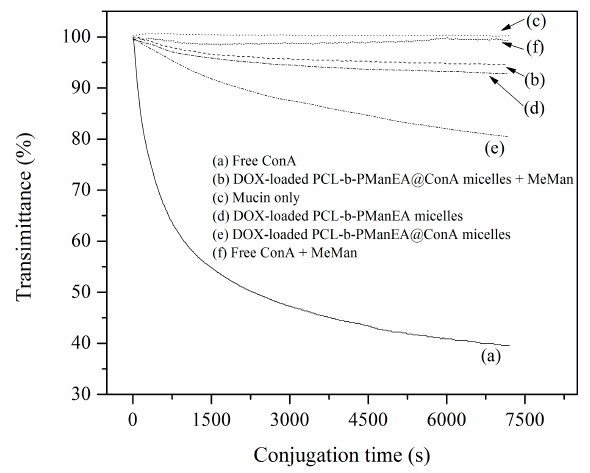
Figure 5. Turbidimetry assay experiment of DOX-loaded PCL1- b -PManEA micelles, and free ConA and DOX-loaded PCL1- b -PManEA@ConA micelles in the absence and presence of MeMan, with mucin.